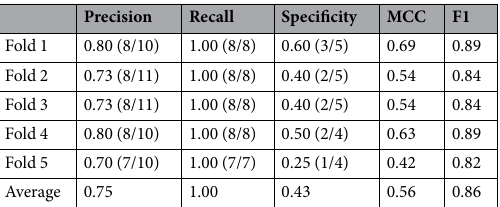
Table 2. Accuracy of our classification results for stratified 5-fold cross validation. Results for individual folds as well as the average accuracy measures over all folds are